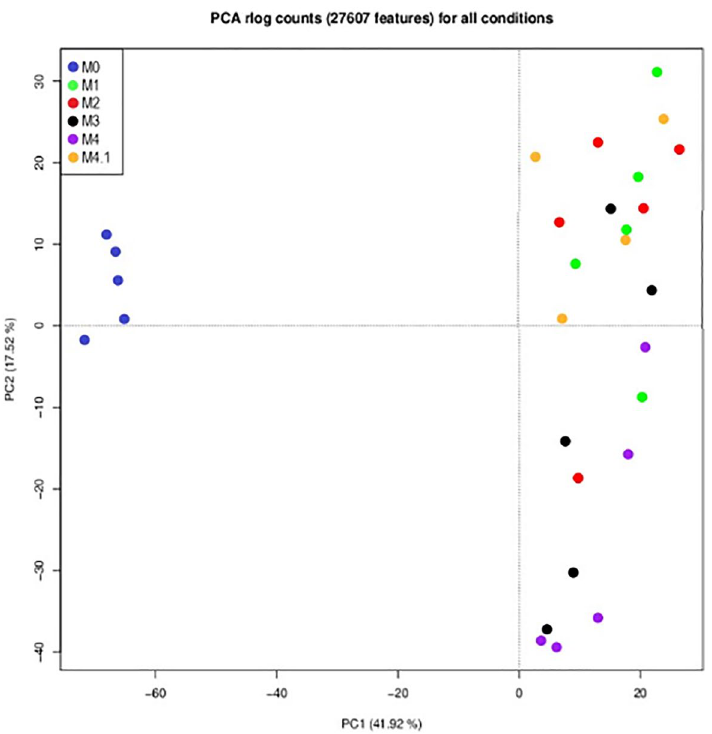
Figure 2. PCA plot of the data. The PCA plot shows all replicates of the different disease stages. Principal components were calculated after variance stabilizing ‘regularized log’ (rlog) transformation of the raw gene counts. Figure made in R version 4.1.2 (https:// www.r- proje ct. org) supplied by YG.